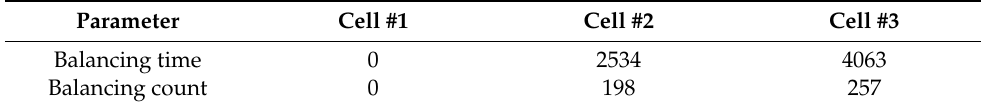
Figure 3. A representative result of cell voltages versus time from a simulation. Table 4. Key parameters traced during the corresponding simulation. Table 4. Key parameters traced during the corresponding simulation.